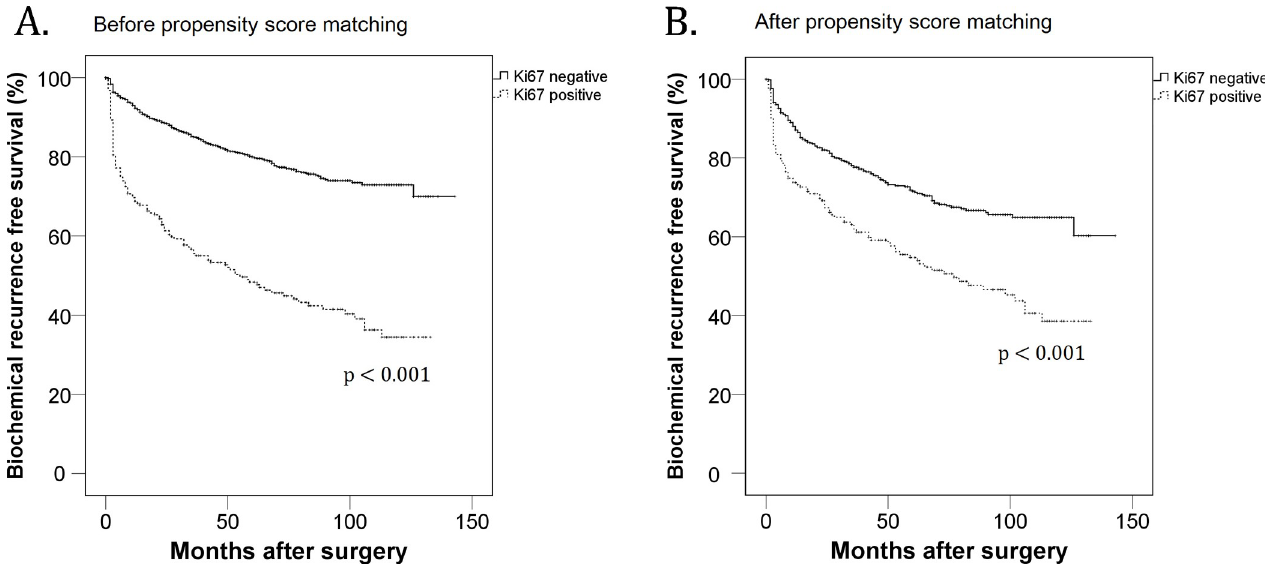
Fig 1. Kaplan-Meier analysis for biochemical recurrence free survival according to the expression of Ki-67 among the entire 1,561 patients (A) and among the 732 patients after propensity scored matching (B).